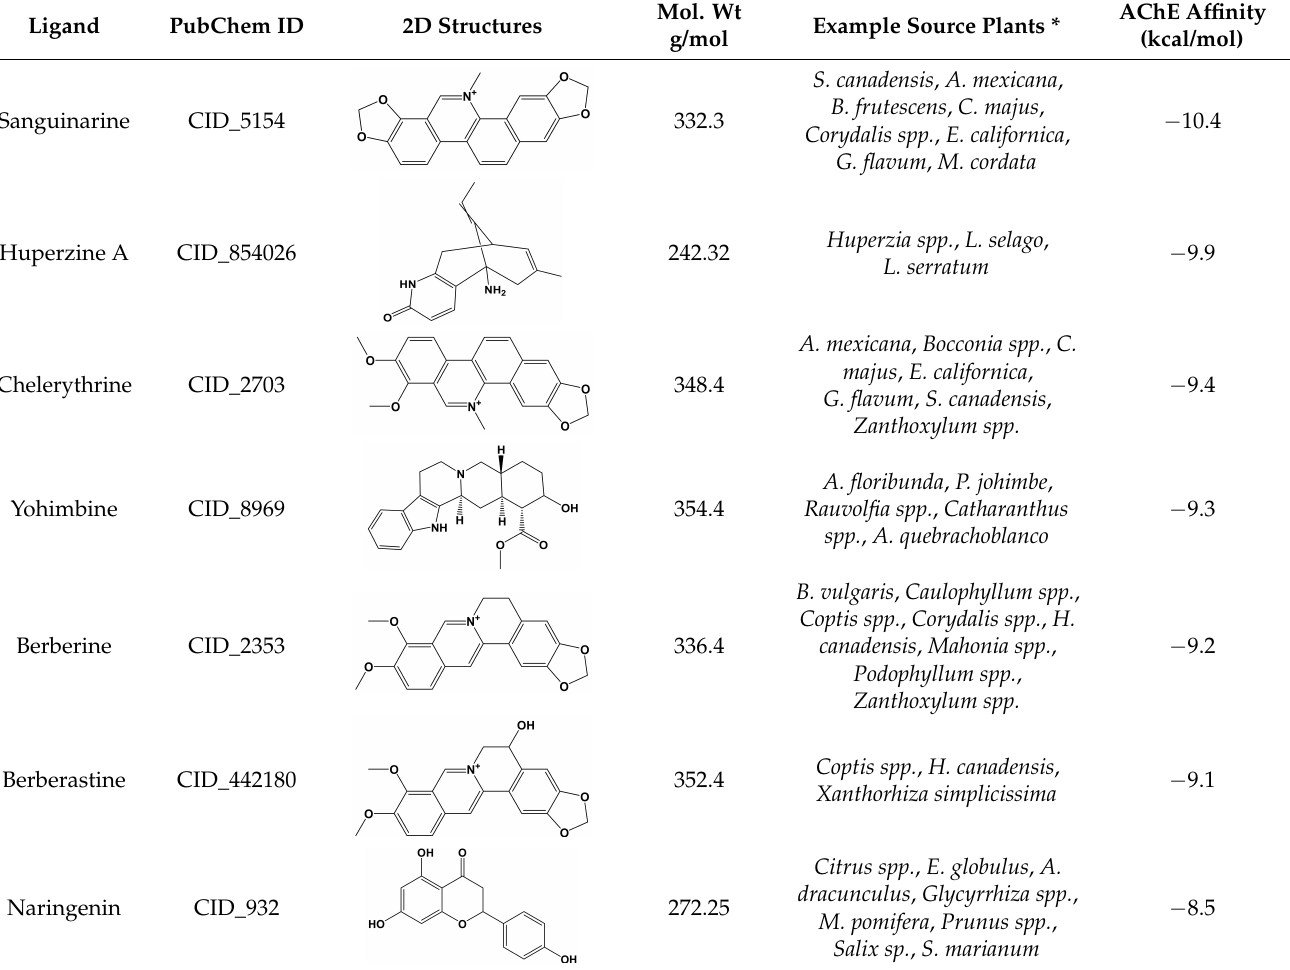
Table 1. Screening of most potent phytochemicals with anti-acetylcholinesterase activity. Mol. Wt Example Source Plants Ligand PubChem ID 2D Structures g/mol